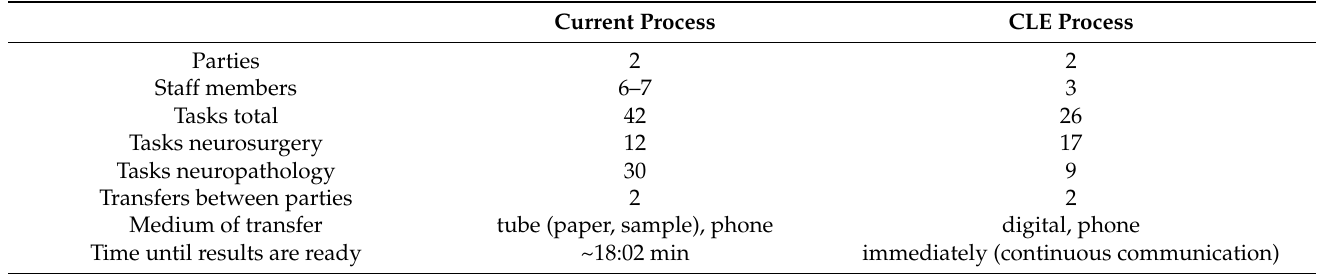
Table 2. Comparison of the current process and the CLE